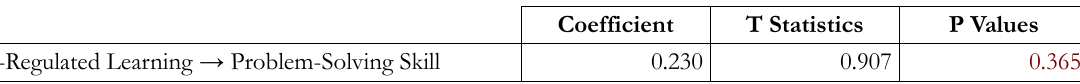
Table 4. Coefficients and testing the influence of structural